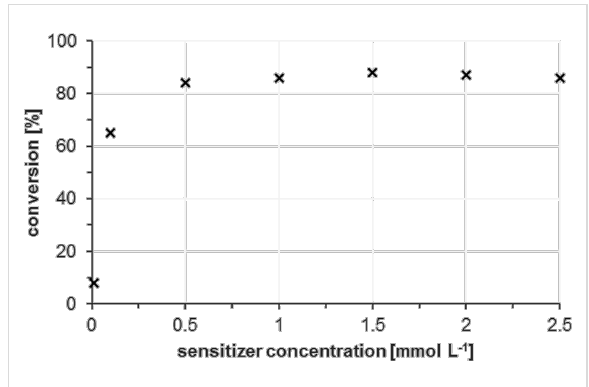
Figure 8: Conversion vs methylene blue sensitizer concentration. Reactions at constant flow rates in acetonitrile at 10 °C; 0.01 M 1a , 2.4 bar, light source: Osram Dulux